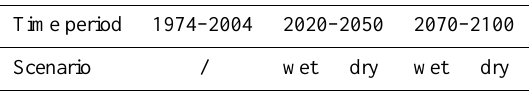
Table 2. Scenarios of climate